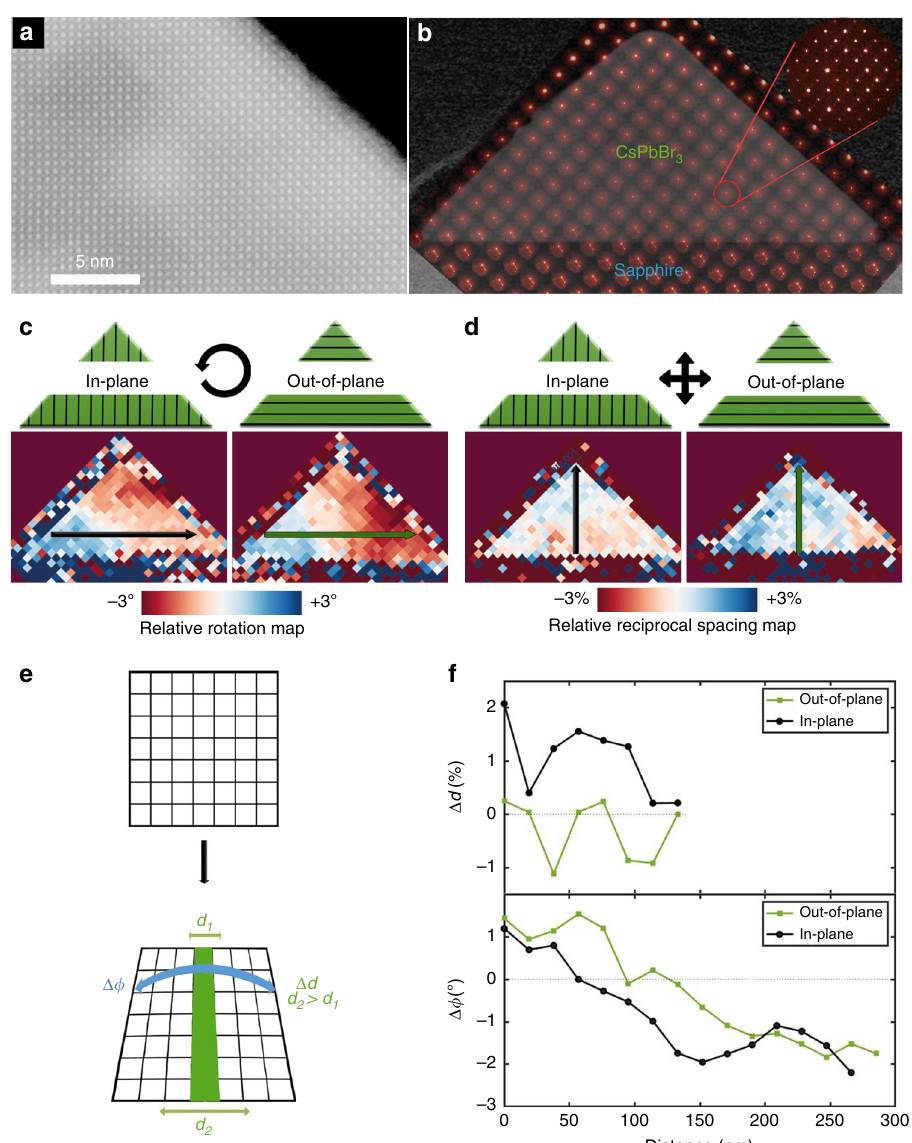
Fig. 4 Scanning electron diffraction analysis of surface-guided CsPbBr 3 nanowires cross-section. ( a ) High magni fi cation image displaying the single- crystal CsPbBr 3 lattice. ( b ) Nanobeam scanning electron diffraction (SED, or 4D-STEM) analysis, a TEM image overlaid with the actual diffraction patterns acquired at every position across the nanowire cross-section. One typical diffraction pattern is enlarged at the inset. For each nanowire cross-section: ( c ) the in-plane and out-of-plane relative reciprocal-lattice rotation map and ( d ) relative reciprocal-lattice spacing map. ( e ) A schematic model that illustrates the real-space distortion of a cubic lattice according to the trends found in the SED analysis for the in-plane direction: Lattice rotation ( Δ ϕ ) and dilated spacings near the substrate ( Δ d ). ( f ) Line pro fi les along the black and green arrows indicated in ( c ) of the real-space lattice spacings difference ( Δ d ) and relative lattice rotation ( Δ ϕ ). Source data are provided as a Source Data fi